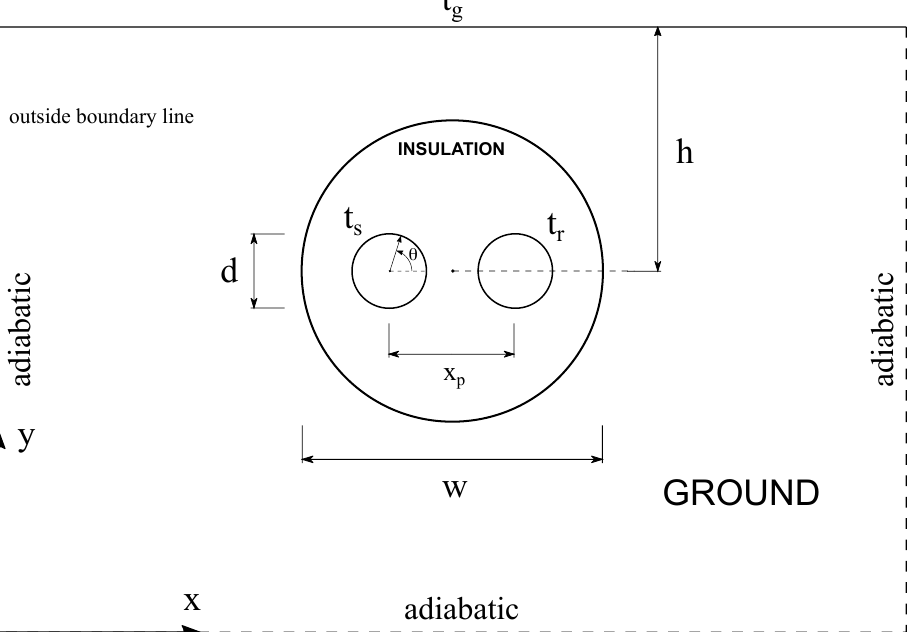
Figure 1. Sketch of the geometry and coordinate